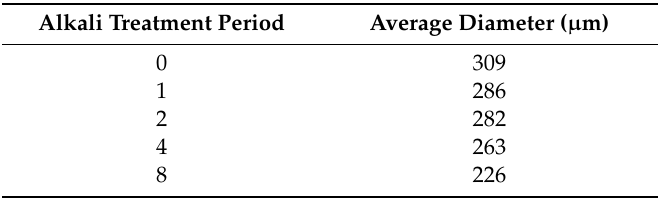
Table 1. The diameter of untreated and alkali treated Typha spp . fiber.